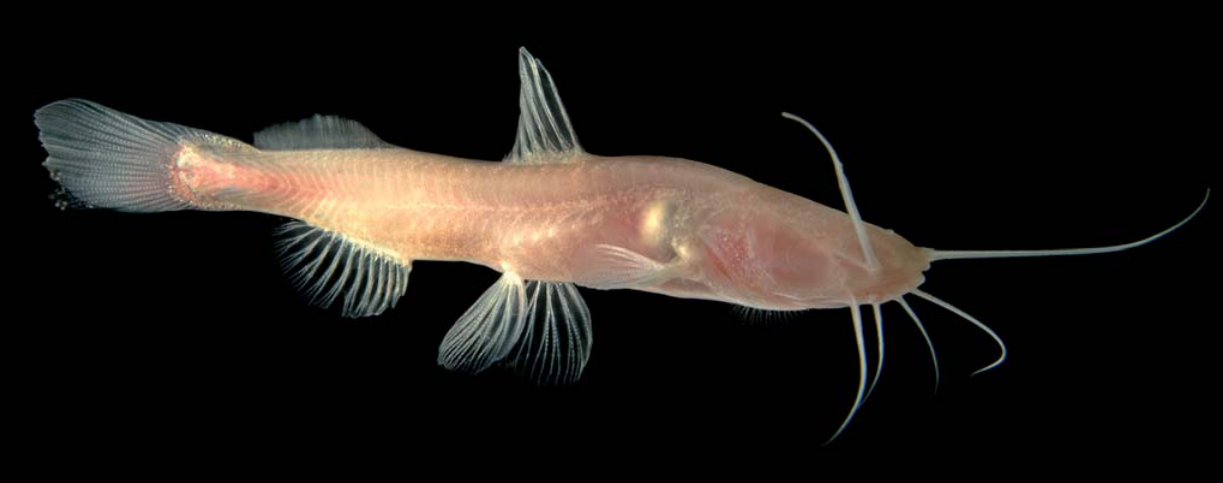
Fig. 13. Rhamdiopsis krugi , 32.5 mm SL, adult, live specimen photographed in aquarium on July 16 th , 2008, unpreserved; Poço Encantado cave, left margin of the rio Una, Municipality of Itaetê, State of Bahia, Brazil. Courtesy of Adriano